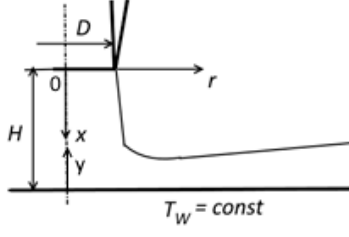
Figure 3. Scheme for the round impinging jet.